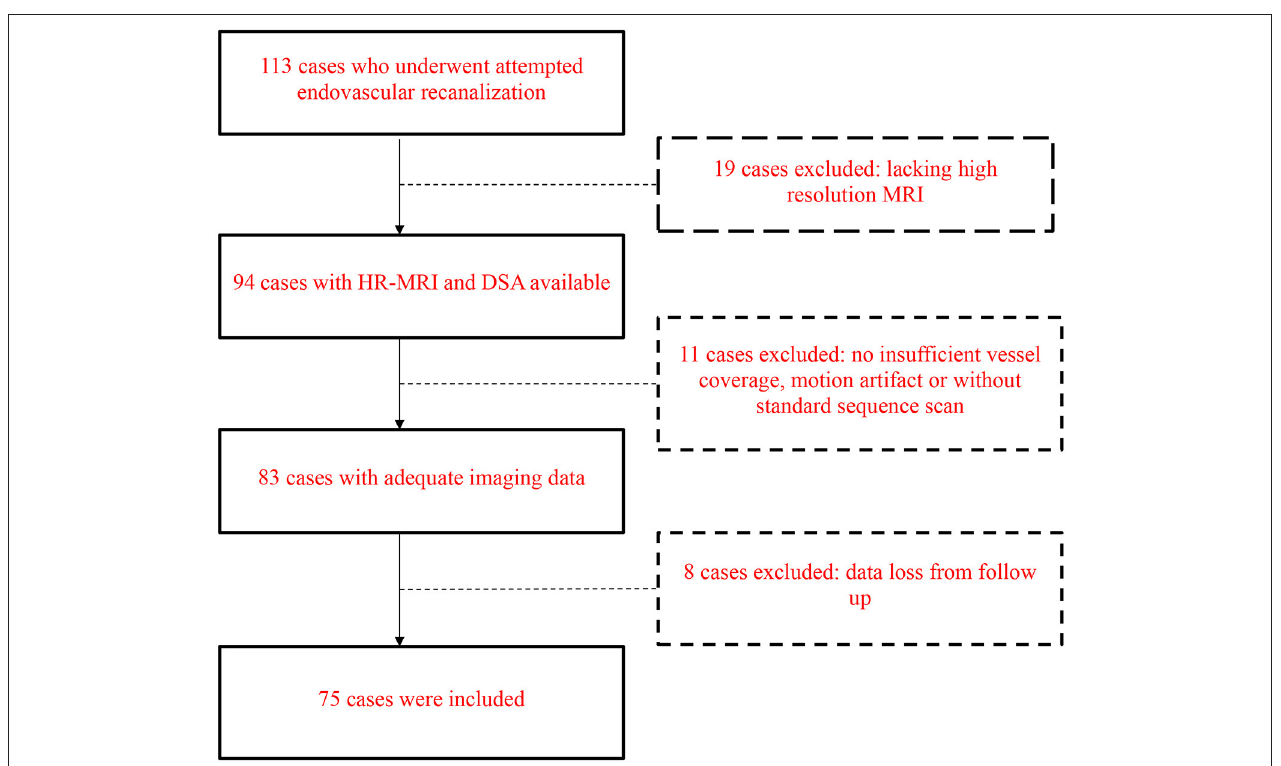
FIGURE 1 | Flow chart of case